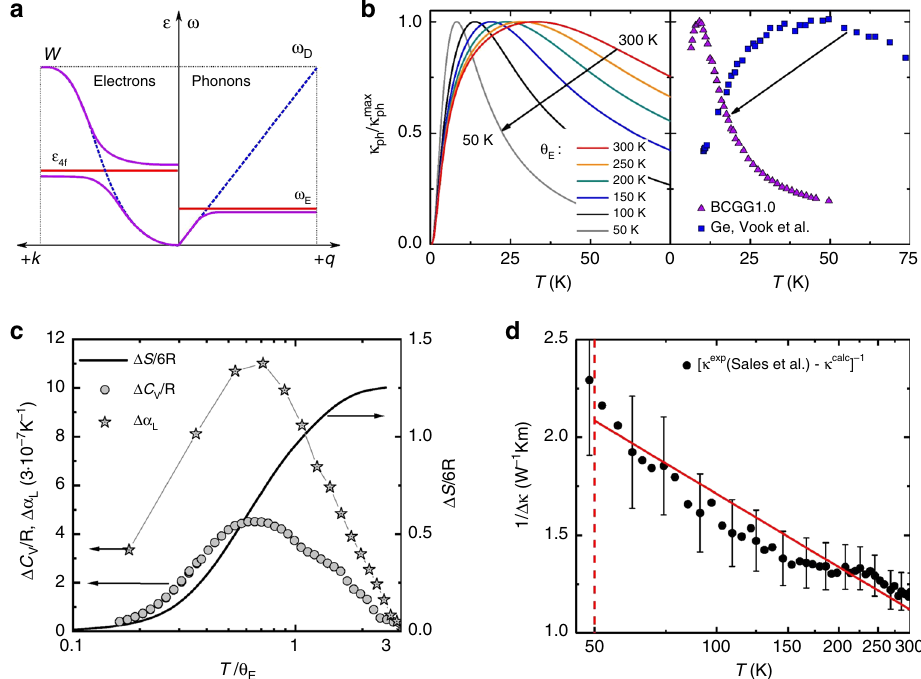
Fig. 3 Comparison of spin and phonon Kondo effect. a Schematic dispersion relations for electrons in heavy electron systems (left) and phonons in an analogously de fi ned “ heavy ” phonon system (right). The blue and red curves represent the non-interacting dispersive and localized entities, respectively, the violet curves the hybridized interacting states. As function of temperature, the system evolves from non-interacting well above the Kondo temperature to interacting well below it. For simplicity, phonon branches above ω E are neglected. This is justi fi ed in real clathrates by the presence of multiple Einstein modes, resulting in multiple anticrossings 13, 14 . The Debye model (blue line, right) assumes ω = v s q where v s is the sound velocity. The new dispersion relation (violet, right) is characterized by the group velocity v g = ∂ ω / ∂ q . It equals the sound velocity only at low wave vectors and frequencies. b Temperature-dependent phonon thermal conductivity, normalized to its maximum, calculated using a modi fi ed Callaway model (Supplementary Note 1) for various Einstein temperatures Θ E (left) and corresponding data for the Ge-based type-I clathrate BCGG1.0 (Supplementary Table 1) and elemental Ge, electron irradiated and annealed at 77 K to similar defect densities 64 (right). c Speci fi c heat and thermal expansion phonon Kondo anomaly, obtained by subtracting the experimental from the theoretical speci fi c heat and thermal expansion curves of Ba 8 Ga 16 Ge 30 (left axis, see Supplementary Figs. 1b and 2b and Methods) and the corresponding entropy (right axis). d The inverse difference of calculated and experimental 41 phonon thermal conductivities of Ba 8 Ga 16 Ge 30 (Supplementary Fig. 3b), showing the − ln T hallmark (full red line) of incoherent Kondo scattering in the spin Kondo effect above the Kondo temperature (dashed vertical line). The error bars represent the error of ±3% speci fi ed for the thermal conductivity data